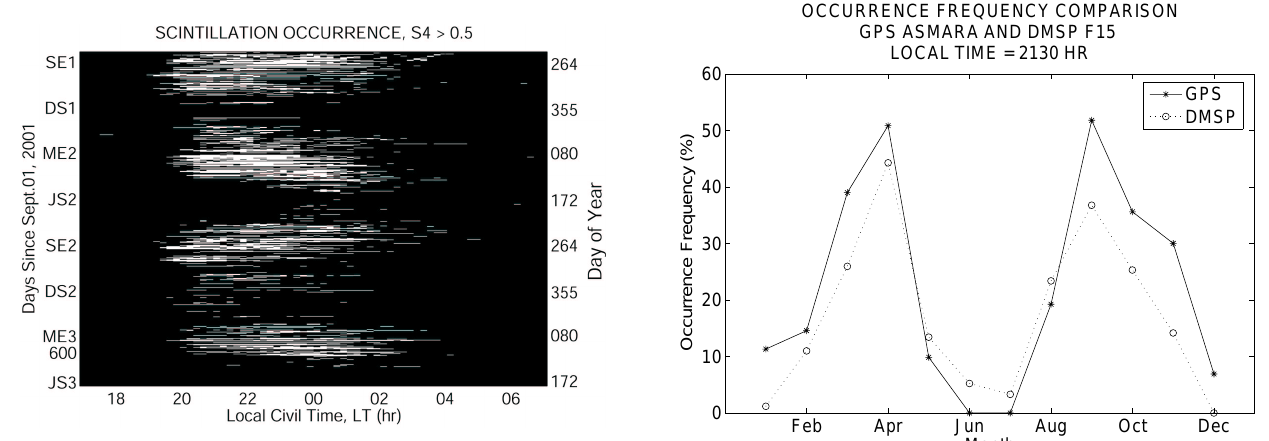
Fig. 6. Monthly average occurrence frequency comparison of As- mara GPS scintillation and DMSP EPB detection. Points are given at the start of the month for the whole month. The figure shows both satellite and ground-based agreement on the symmetry of equinoc- tial